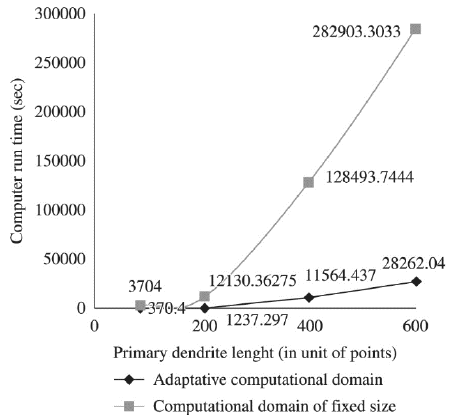
Figure 11. Variation of computer run time as a function of primary dendrite length, in units of points, for binary alloy ( Fe-C